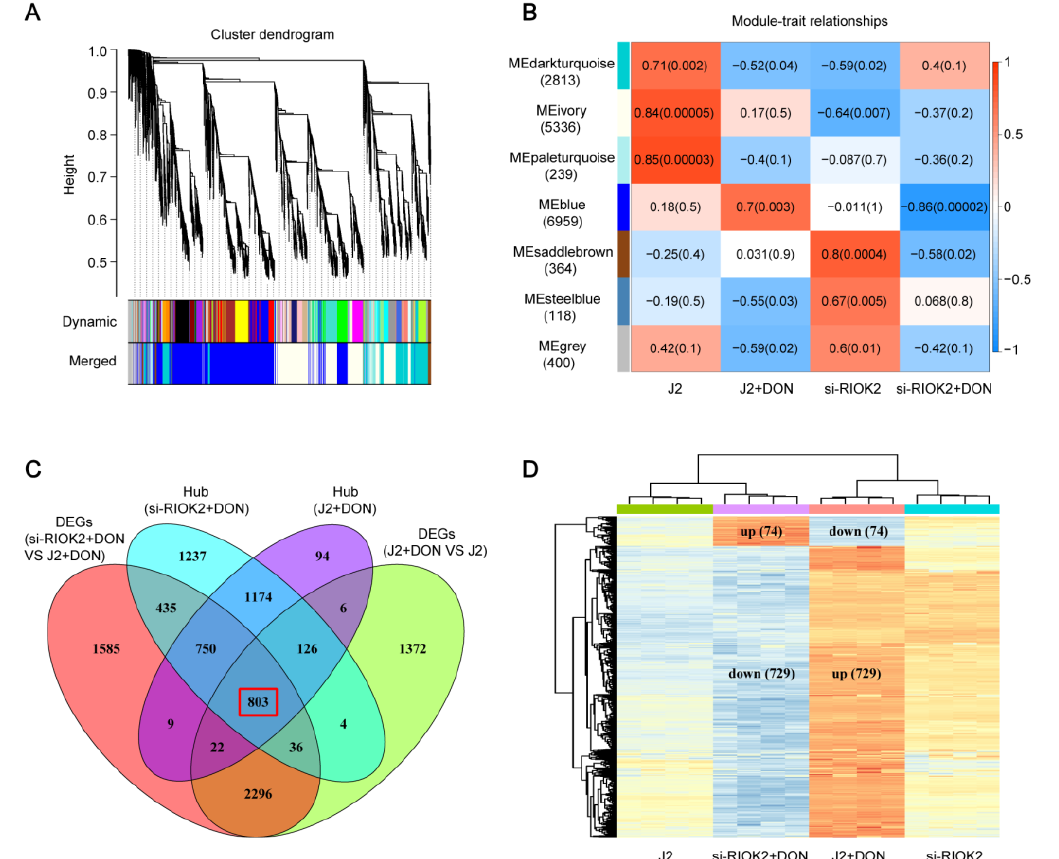
Figure 4. WGCNA showing the mechanism of the downstream regulation of the RIOK2 gene. ( A ) WGCNA cluster dendrogram and module assignment. Colors in horizontal bars indicate modules, and branches refer to highly connected gene clusters. ( B ) Heatmap of the correlation between the module eigengenes and different treatment groups. Each cell contains the correlation coefficient and p -value. ( C ) Overlapping differentially expressed genes and WGCNA blue module hub genes un- cover key hub DEGs in DON-induced cytotoxicity regulation. ( D ) Cluster analysis graph of